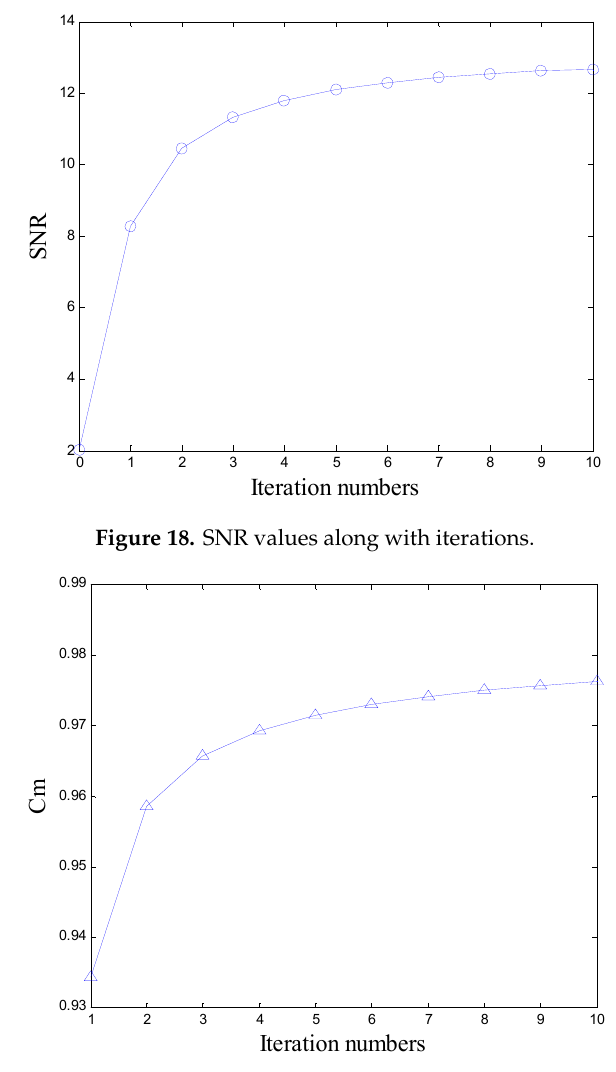
Figure 19. Cm values along with iterations.